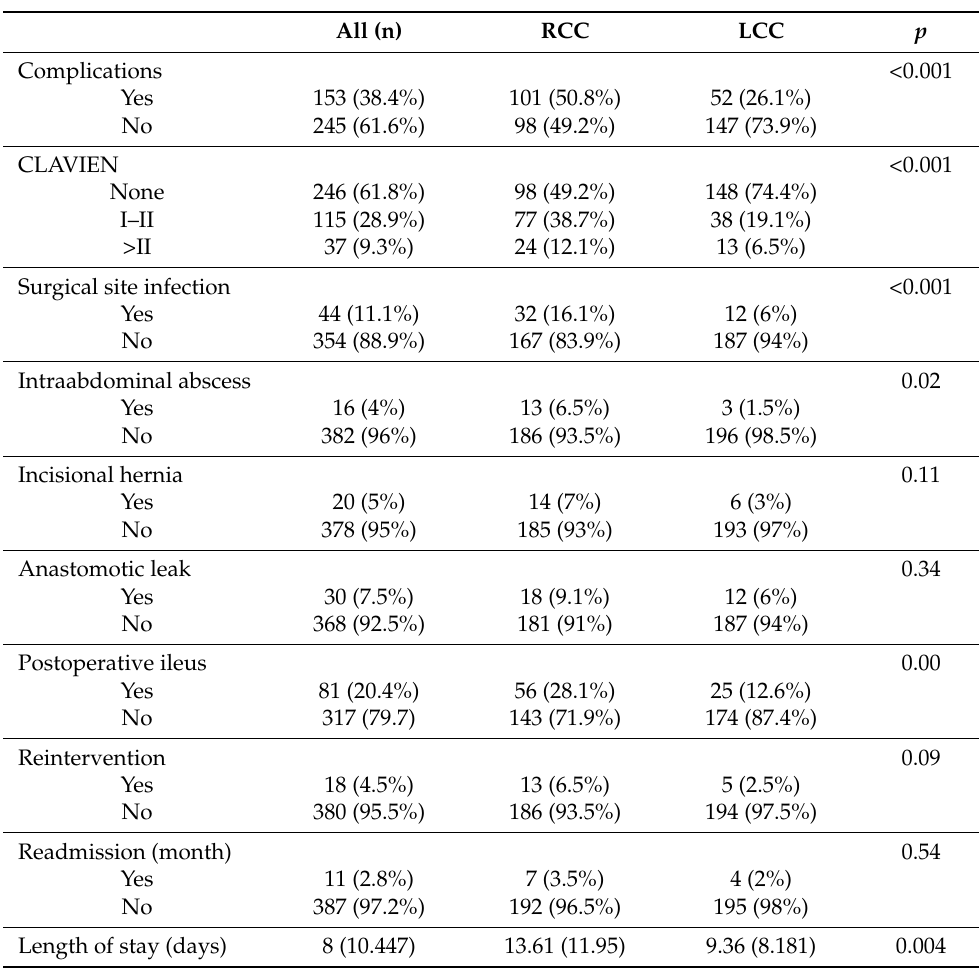
Table 3. Postoperative